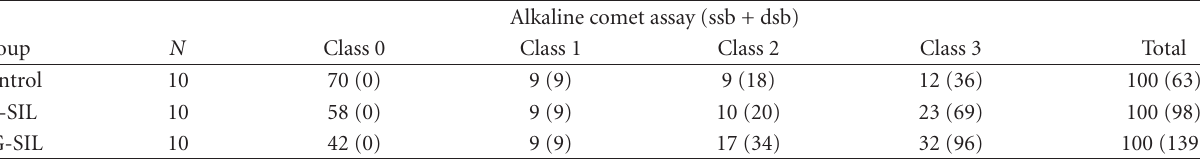
Table 2: Distribution of percentage of DNA damage evaluated in alkaline comet assay (ssb + dsb) in control, LG-SIL, and HG-SIL women.